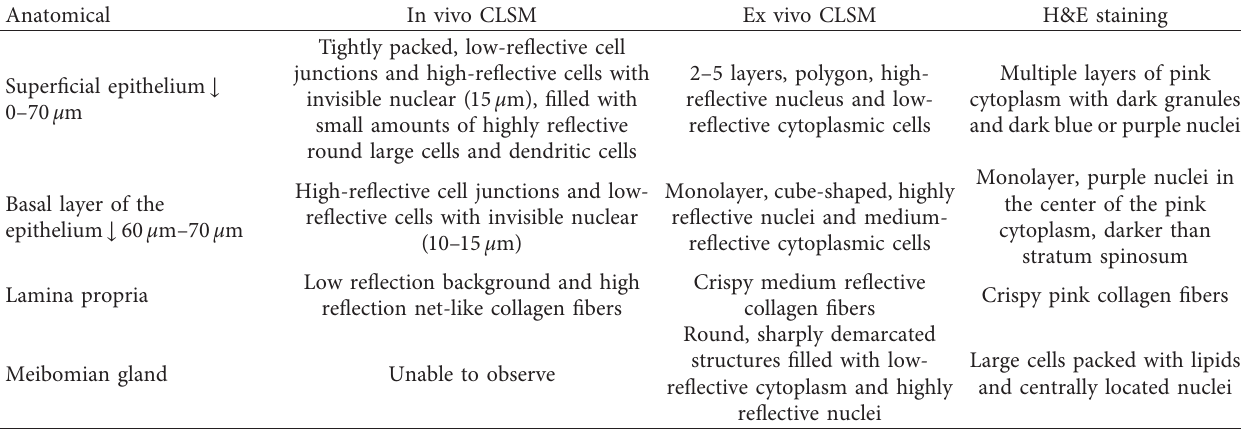
Table 2: List of in vivo and ex vivo CLSM features of healthy palpebral conjunctiva part of the eyelid margin and their histological correlates in H&E